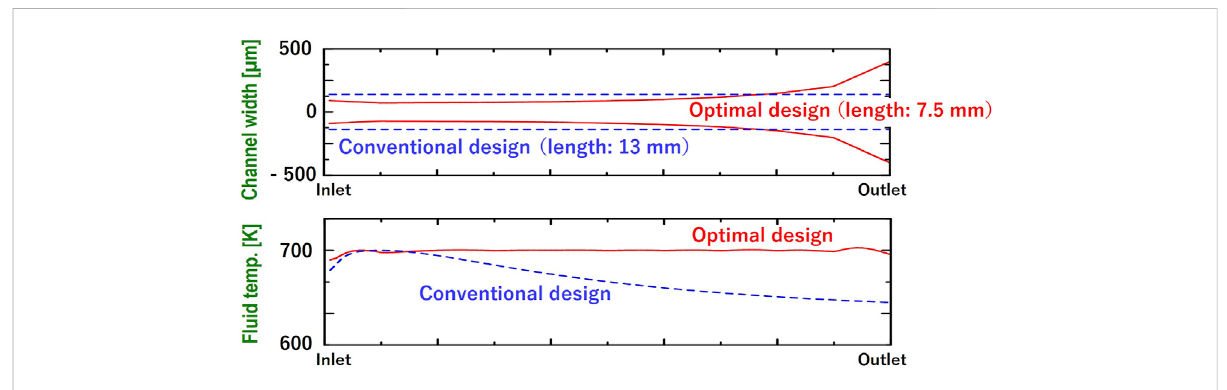
FIGURE 6 Optimal channel width (upper) and temperature pro fi les